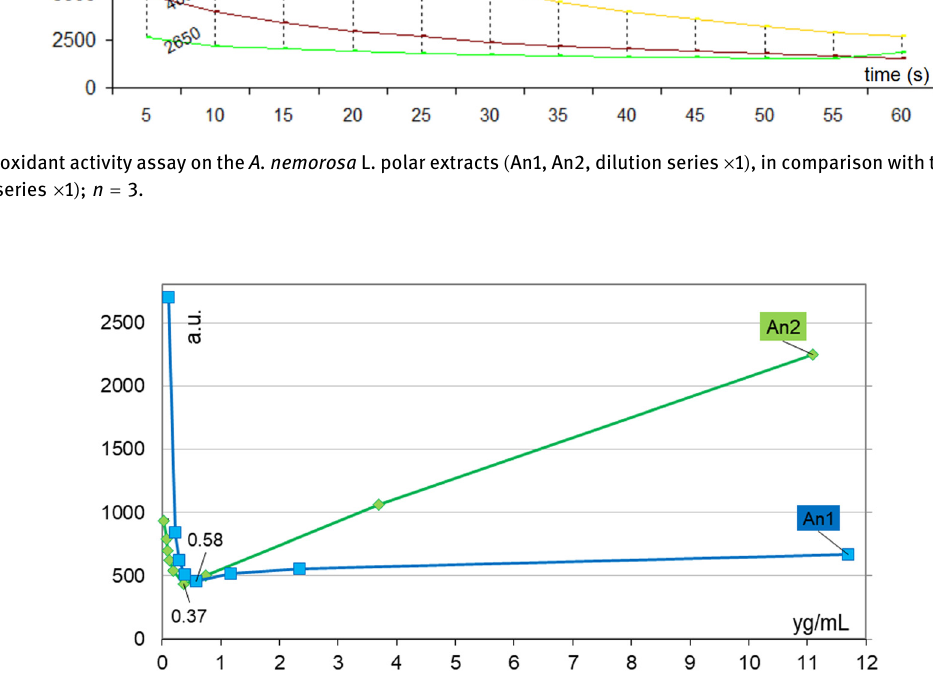
Figure 4: IC 50 assay on the A. nemorosa L. extracts ( An1, An2, eight dilution series, n = 6 )